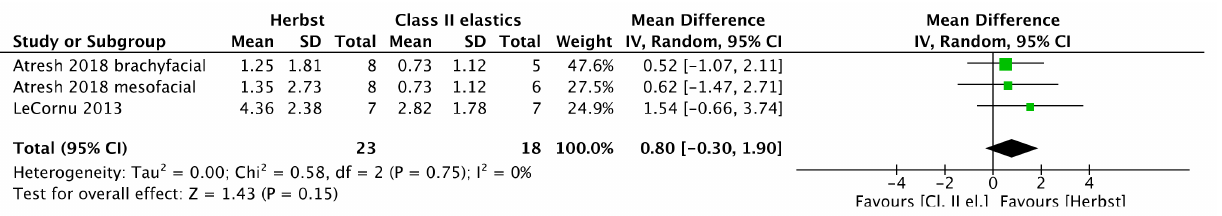
Figure 10. Forest plot of the B point anteroposterior changes using the random effects model [43,44].